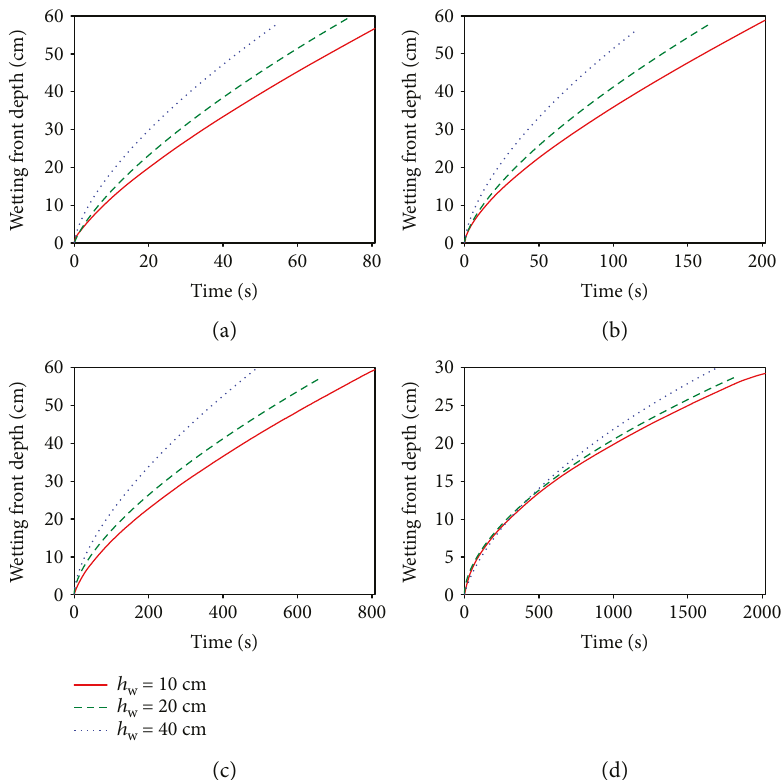
Figure 4: Wetting front depth of sand versus time: (a) B35, (b) B60, (c) B150, and (d) B320. The column length of sands B35, B60, and B150 was 60 cm and of sand B320 was 30